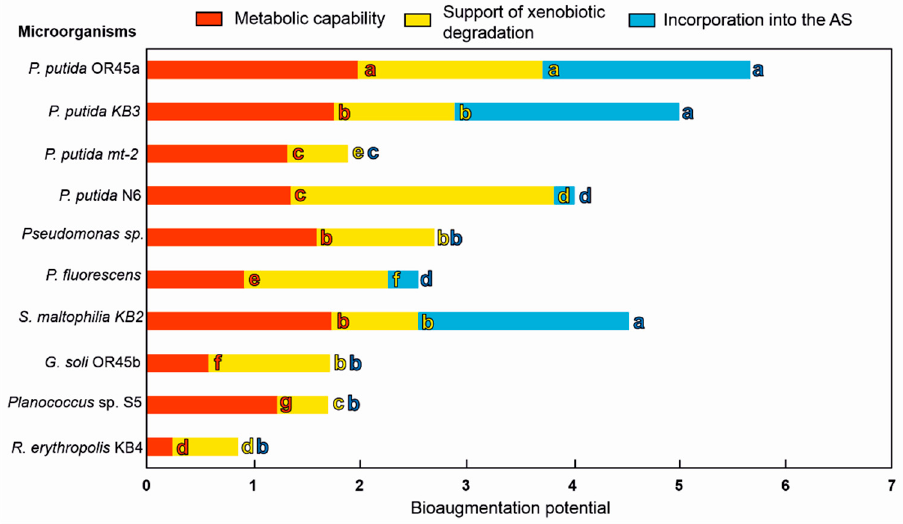
Figure 6. Comparison of the bioaugmentation potential of the tested bacterial strains.